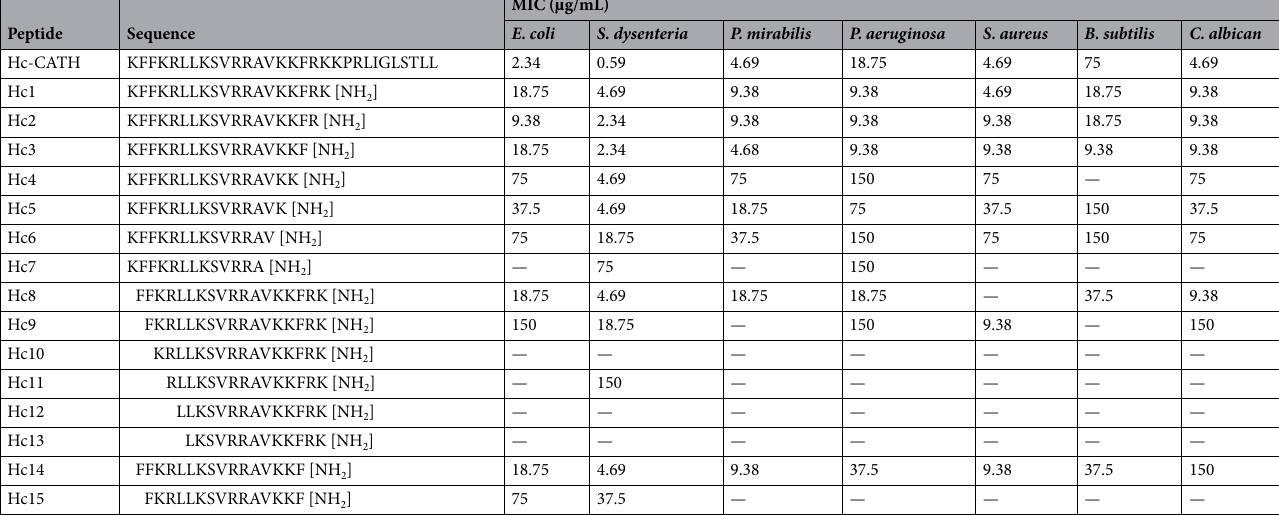
Table 1. Antimicrobial activities of Hc-CATH and its truncated derivatives. MIC: minimal inhibitory concentration. These concentrations represent the mean values of three independent experiments performed in duplicate. —, no detectable activity in the inhibition zone assay at peptide dose of 2